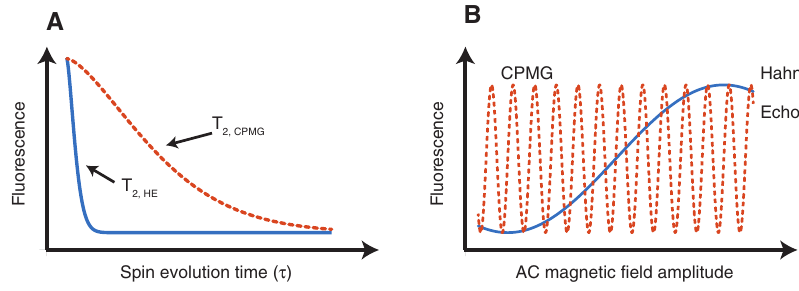
Figure 7: AC magnetometry protocols. (A) Schematic T decoherence curves for Hahn echo and CPMG-32 sequences. Improved decoupling from interactions with the spin bath 2 environment results in an extended CPMG T decoherence time compared to the Hahn echo T 2 T for CPMG leads to increased magnetic field sensitivity, as indicated by the slope of the CPMG magnetometry curve. Hahn echo is much 2 less sensitive, exhibiting an oscillation similar to CPMG over a much larger magnetic field amplitude